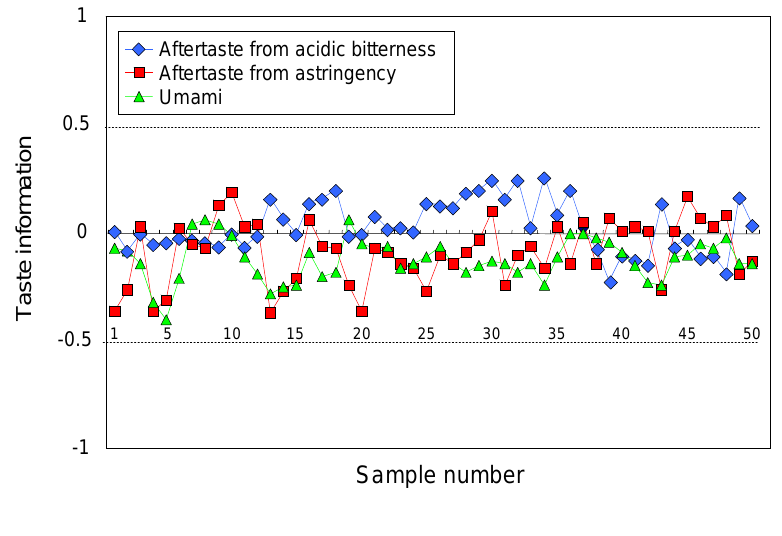
Figure 20. Differences between green tea lots (Adapted from [96]).